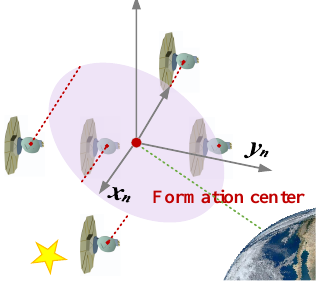
Figure 11. Schematic diagram of IRASSI.